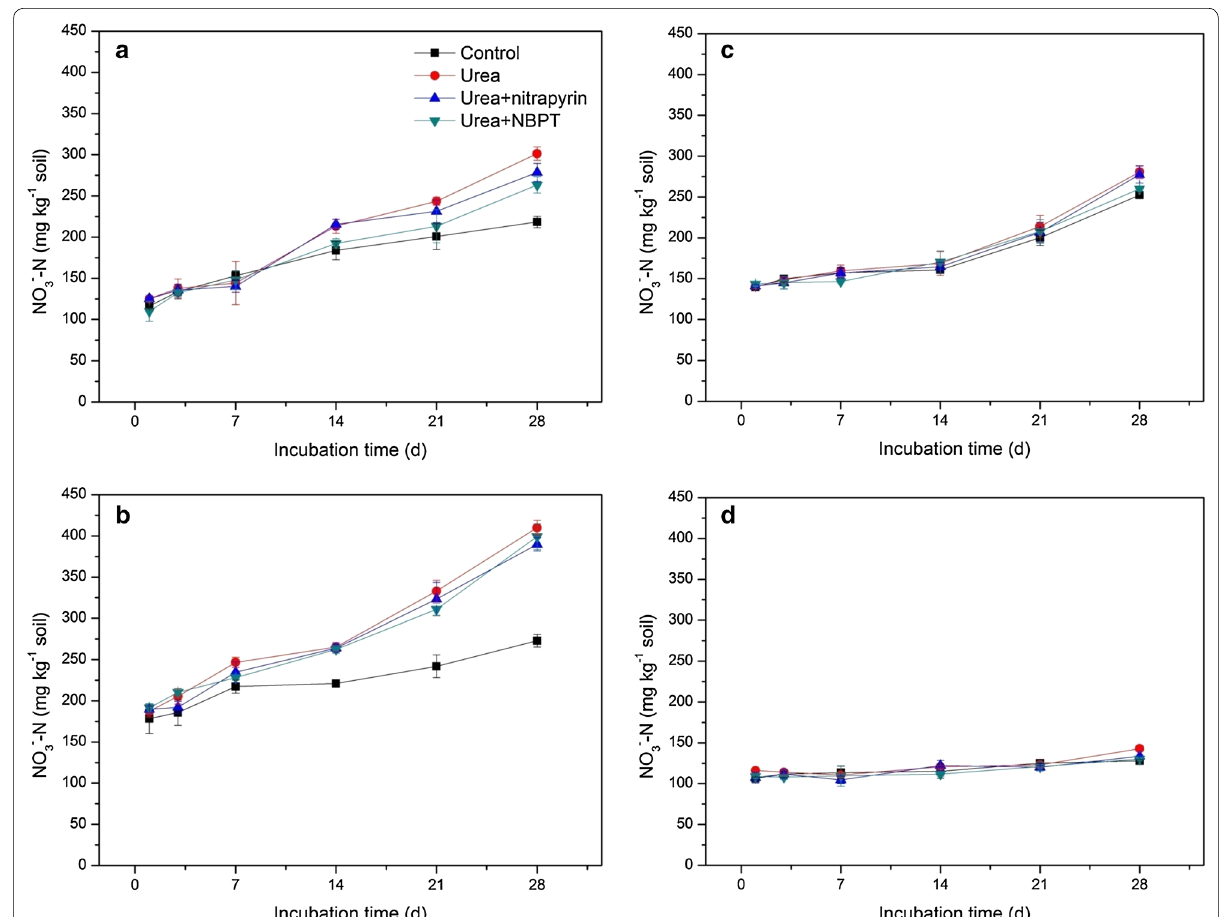
Fig. 2 The variation of NO 3 − ‑N concentrations as affected by applications of urea, nitrification inhibitor (nitrapyrin) and urease inhibitor (NBPT) at different pH levels. Error bars indicate standard deviation of mean ( n